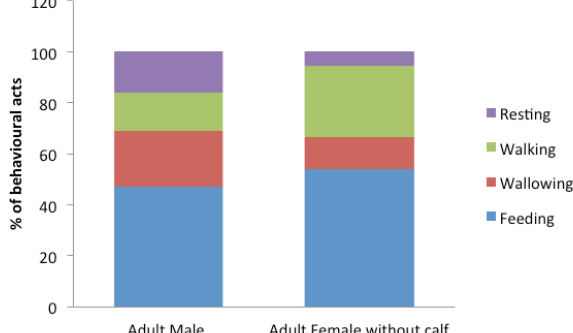
Figure 12. Adult male and adult female (without calf) comparison of behavior activity.